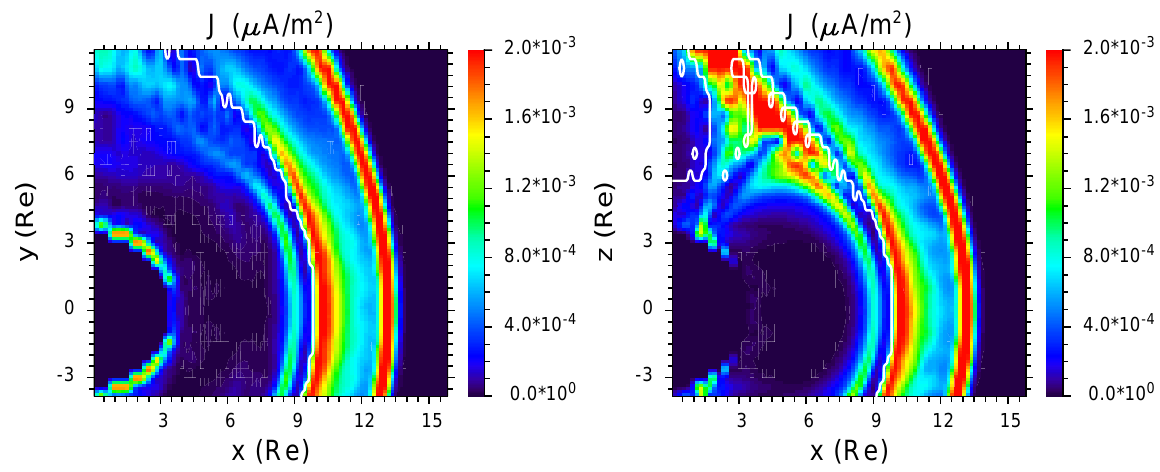
Fig. 6. The current density in the z =0 plane (the left panel) and the y =0 plane (the right panel). The open-closed magnetic field boundary is shown as a white zigzag curve in each of the